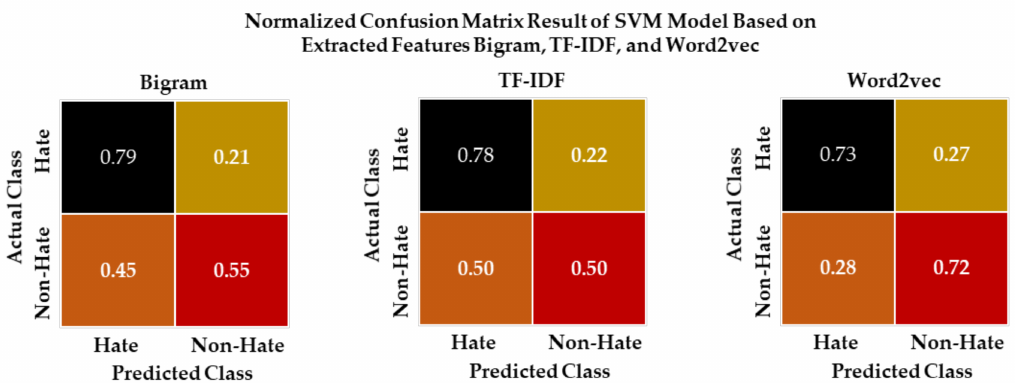
Figure 6. Confusion matrix of sample binary SVM models based on extracted